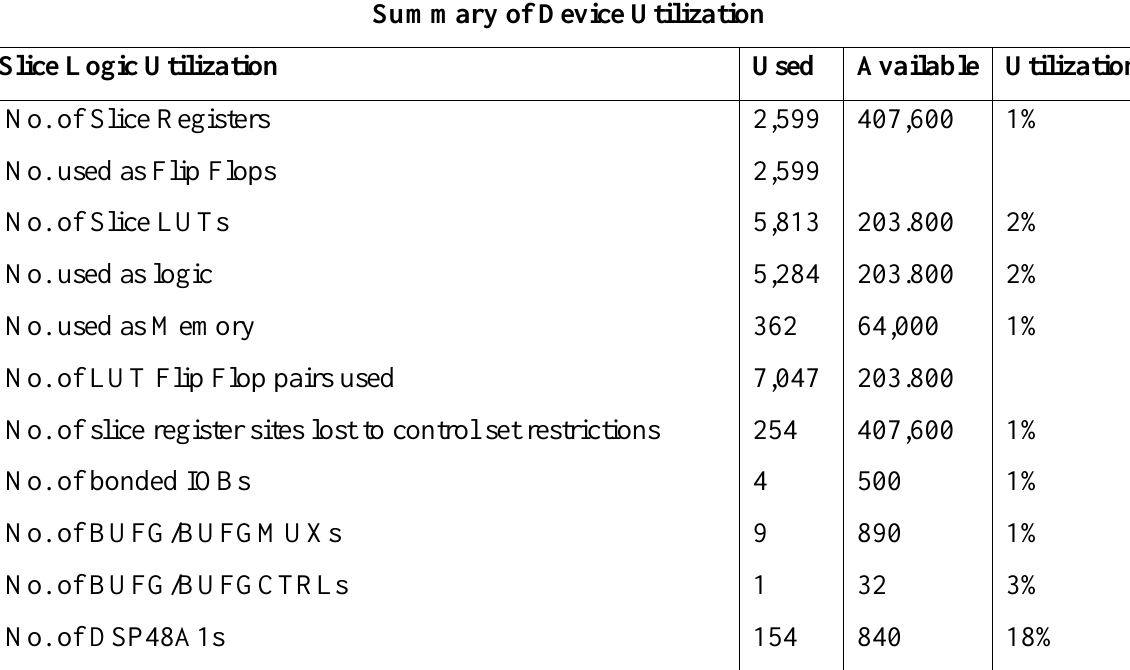
Table 1. Kintex 7 device overview for MS resources.